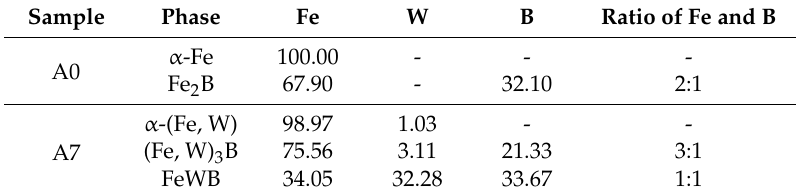
Table 2. Composition of phases in typical cast alloys confirmed by WDX (at %).